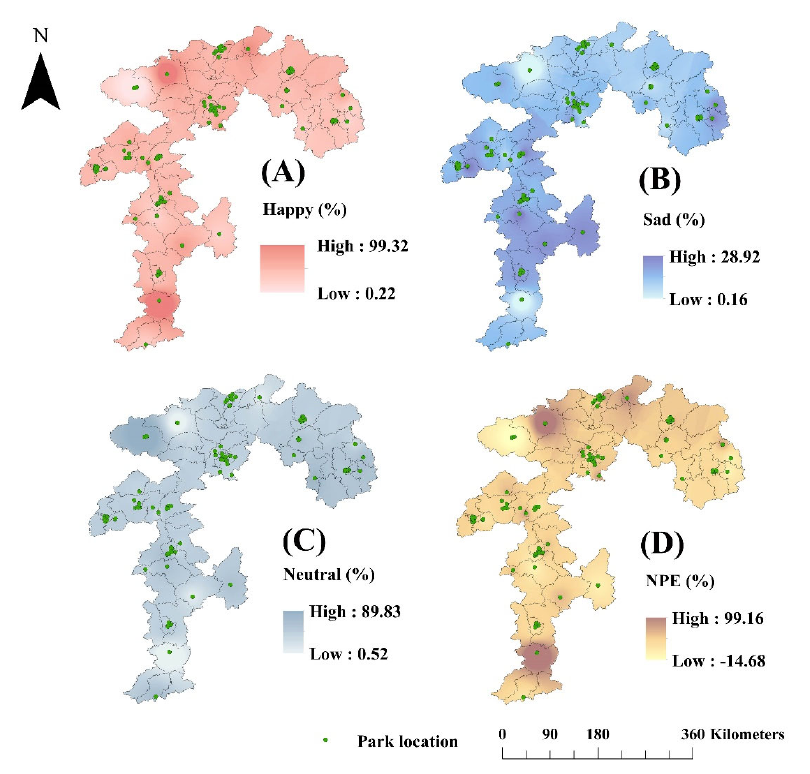
Figure 4. Spatial distributions of happy ( A ), sad ( B ), neutral ( C ), and net positive emotion index (NPE; happy score minus sad score) ( D ) in Jiangxi. (NPE; happy score minus sad score) ( D ) in